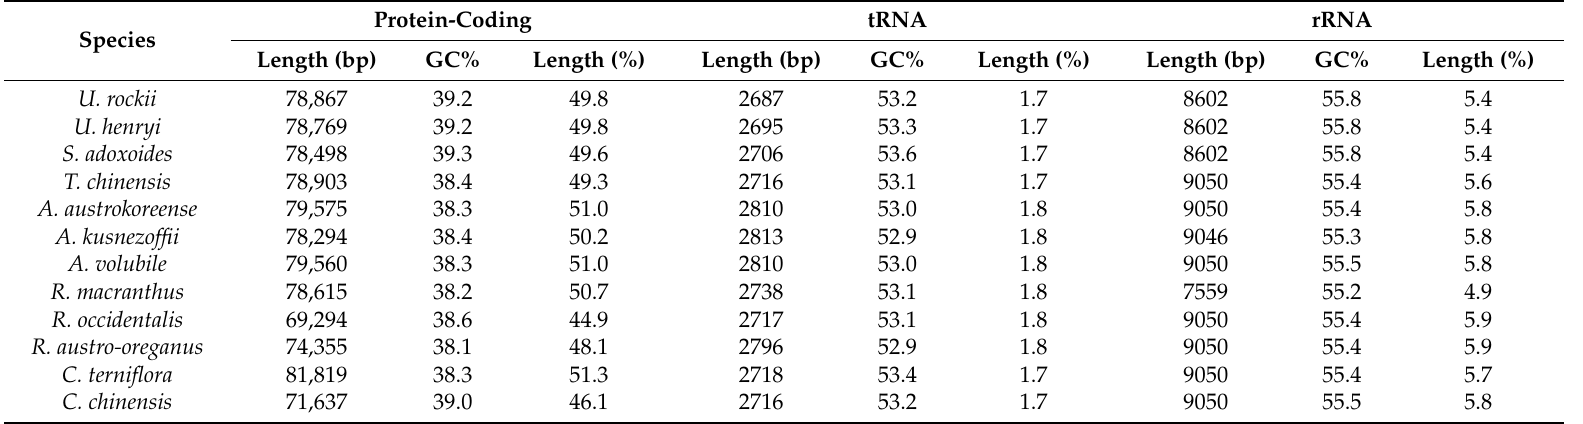
Table 2. Comparison of the sizes of coding and non-coding regions among